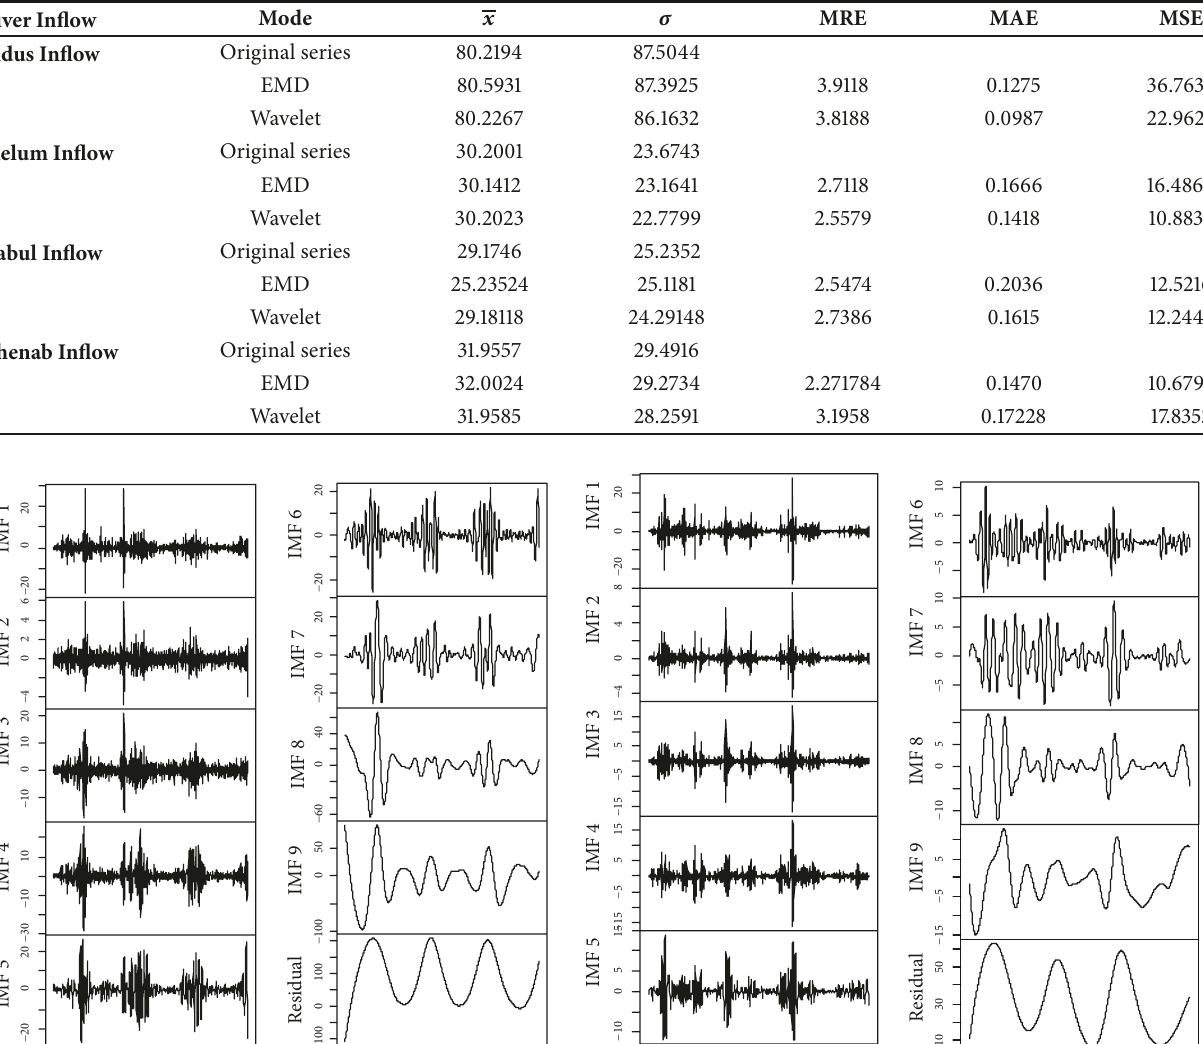
Table 2: Statistical measures of WA- and EMD-based denoised rivers inflow of four hydrological time series data sets.